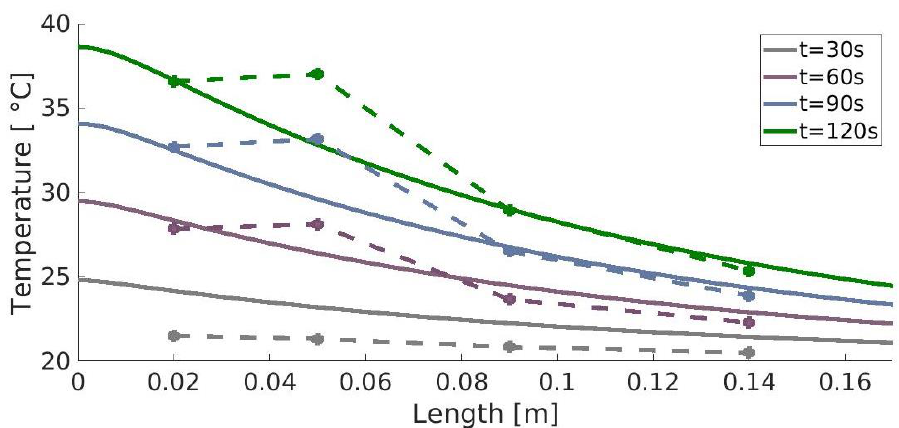
Figure A1. Temperature profiles for Experiment A (EM heating with no water flooding). The continuous lines represent the model’s solution, and the dots represent data obtained by optical thermometers [20].